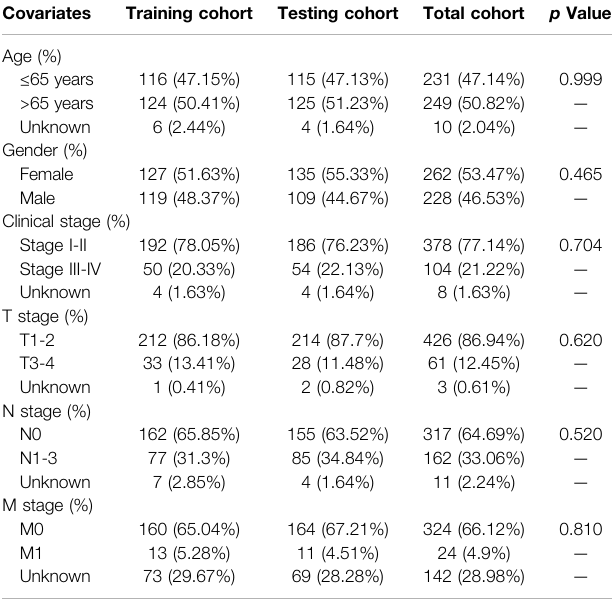
TABLE 1 | Characteristics of patients in the training, testing, and total cohorts. Covariates Training cohort Testing cohort Total